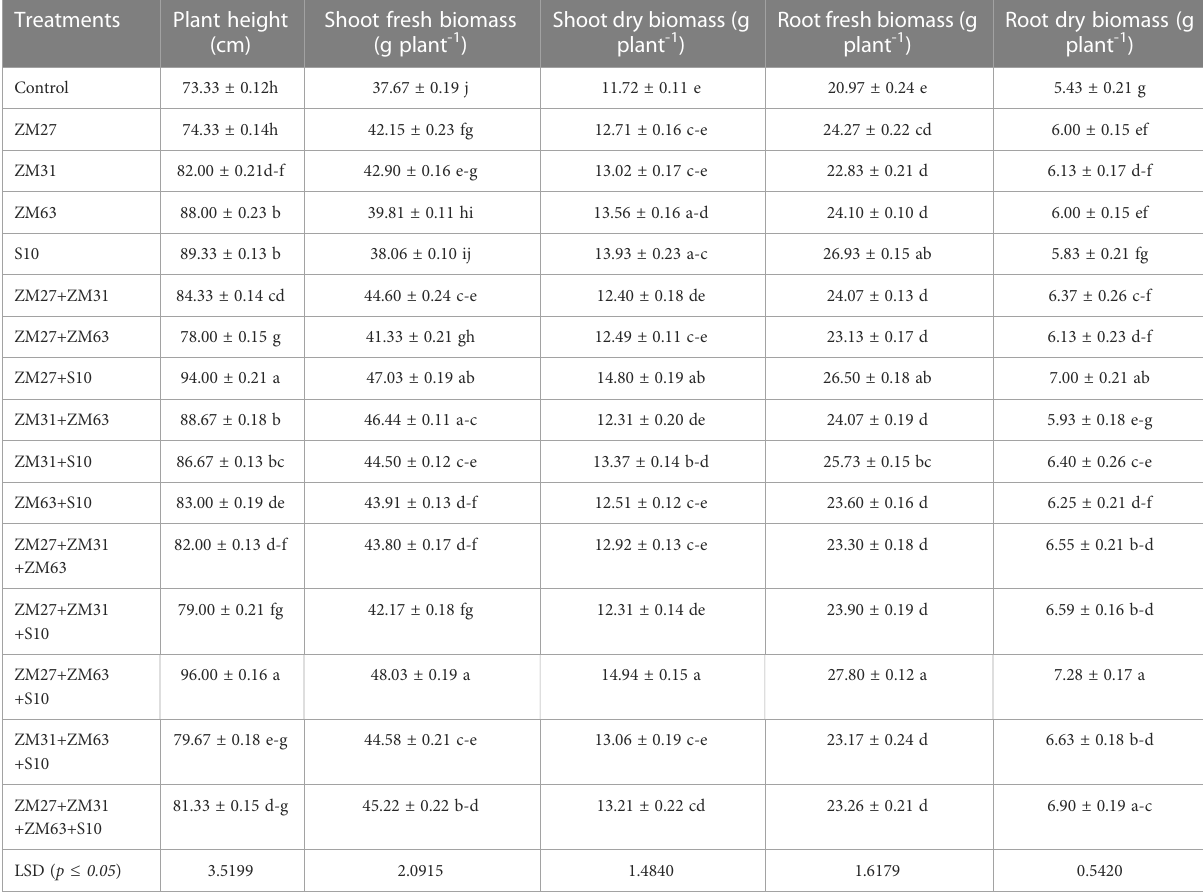
TABLE 1 Effect of novel bio inoculants on growth parameters of maize in the pot trial.